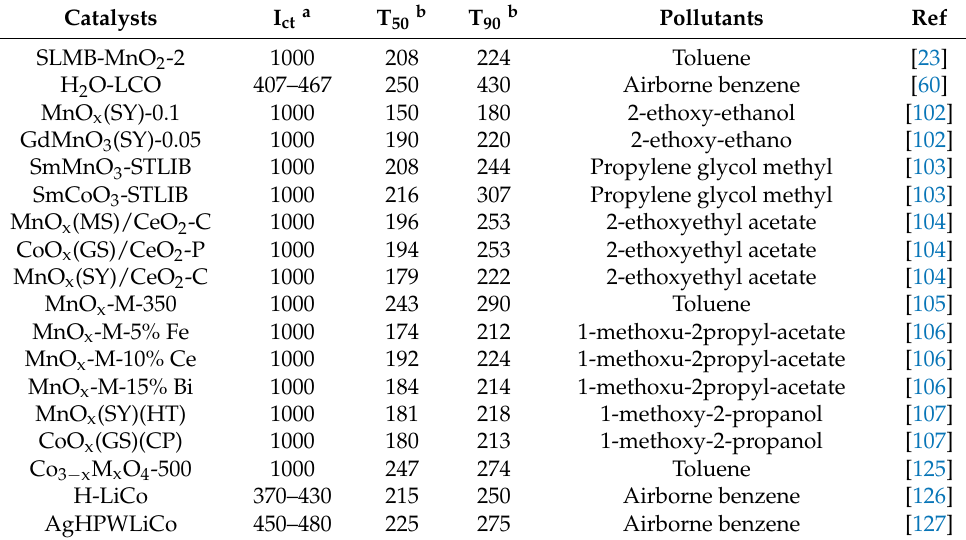
Table 1. The relationship between catalytic performance of different LIBs-based thermocatalysts and